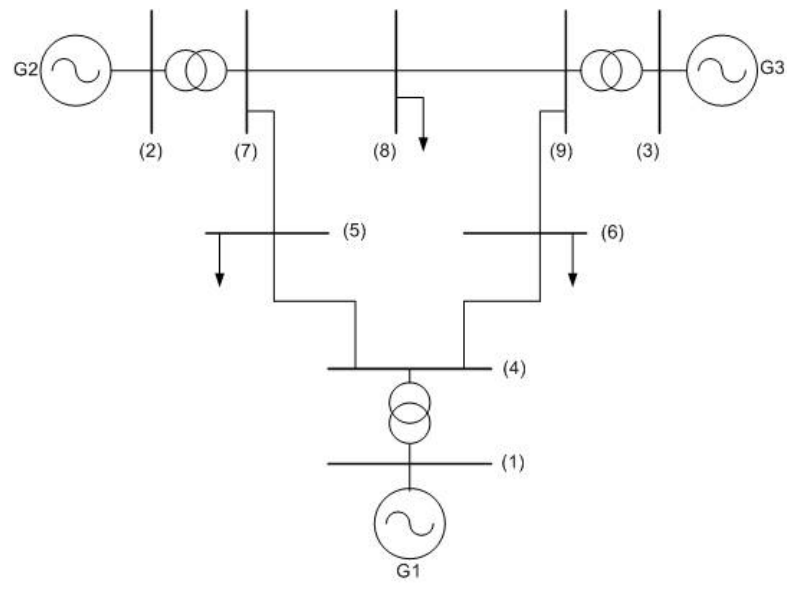
Figure 5. Three-machine–nine-busbar system [31].